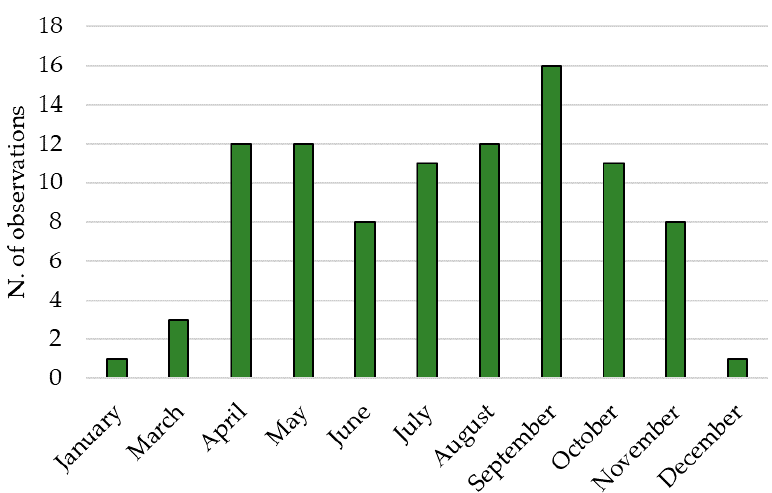
Figure 5. Monthly distribution of the observation of the black weevil Aclees taiwanensis during the year in Southern Europe (2008–2020).